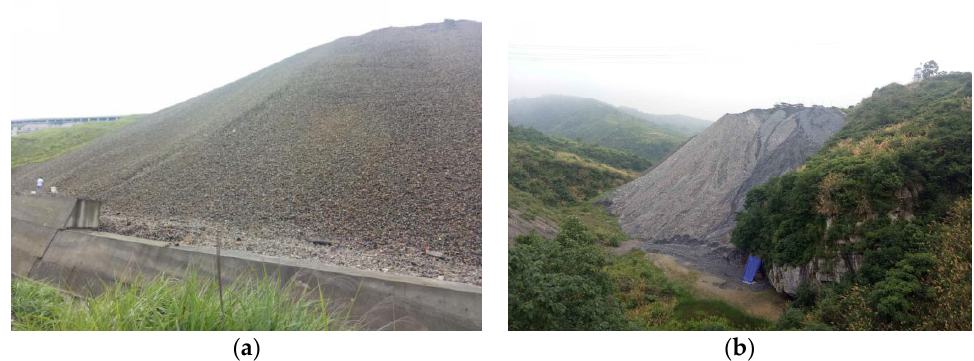
Figure 1. The ATWRs in XKS: ( a ) ATWRs occupy valuable land resource; ( b ) ATWRs destroy the ecological environment.